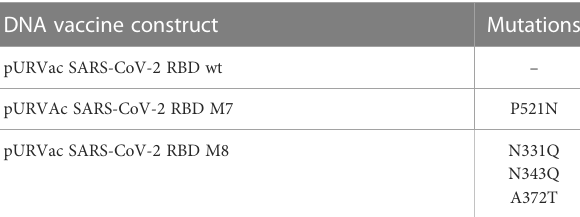
TABLE 1 Glycan engineered SARS-CoV-2 RBD DNA vaccine constructs evaluated in this